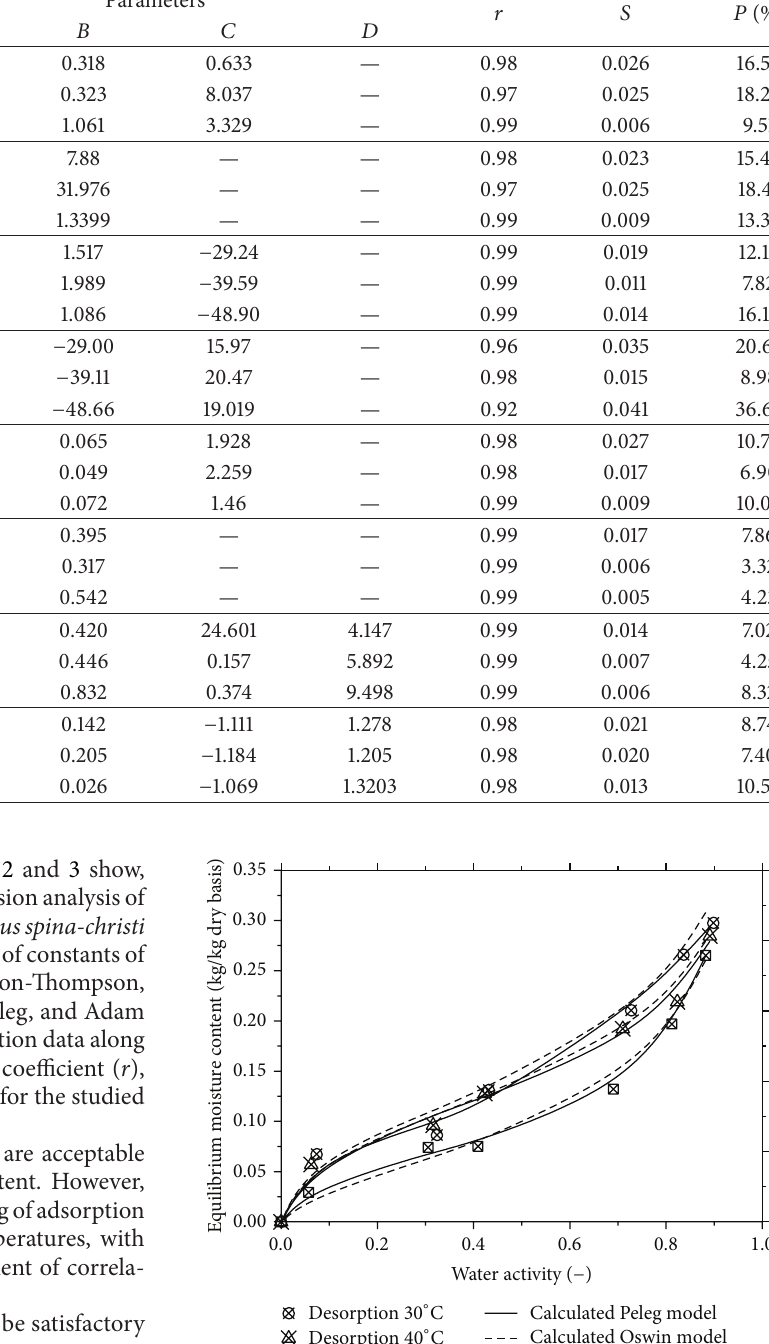
moisture contents were determined by using both Peleg and Oswin models in combination with